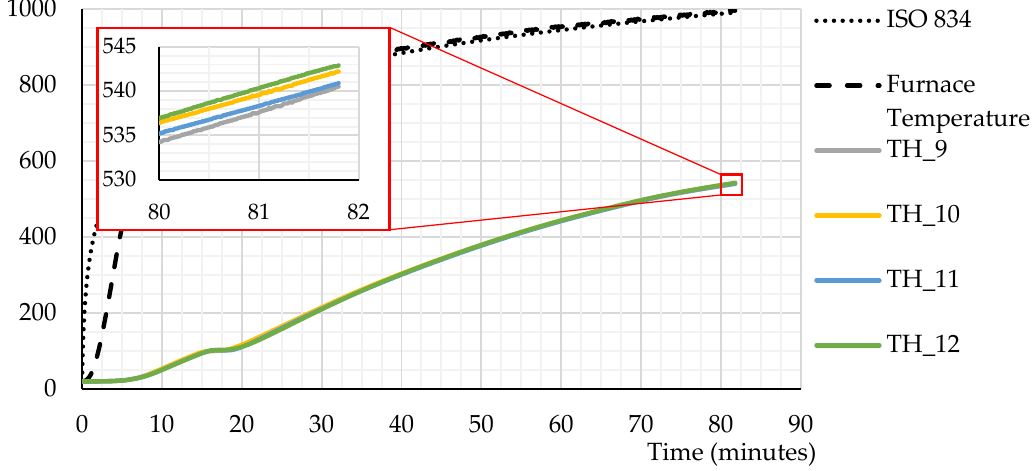
Figure 11. Evolution of the temperature of the four thermocouples in group 3 of specimen 5 of SSC.